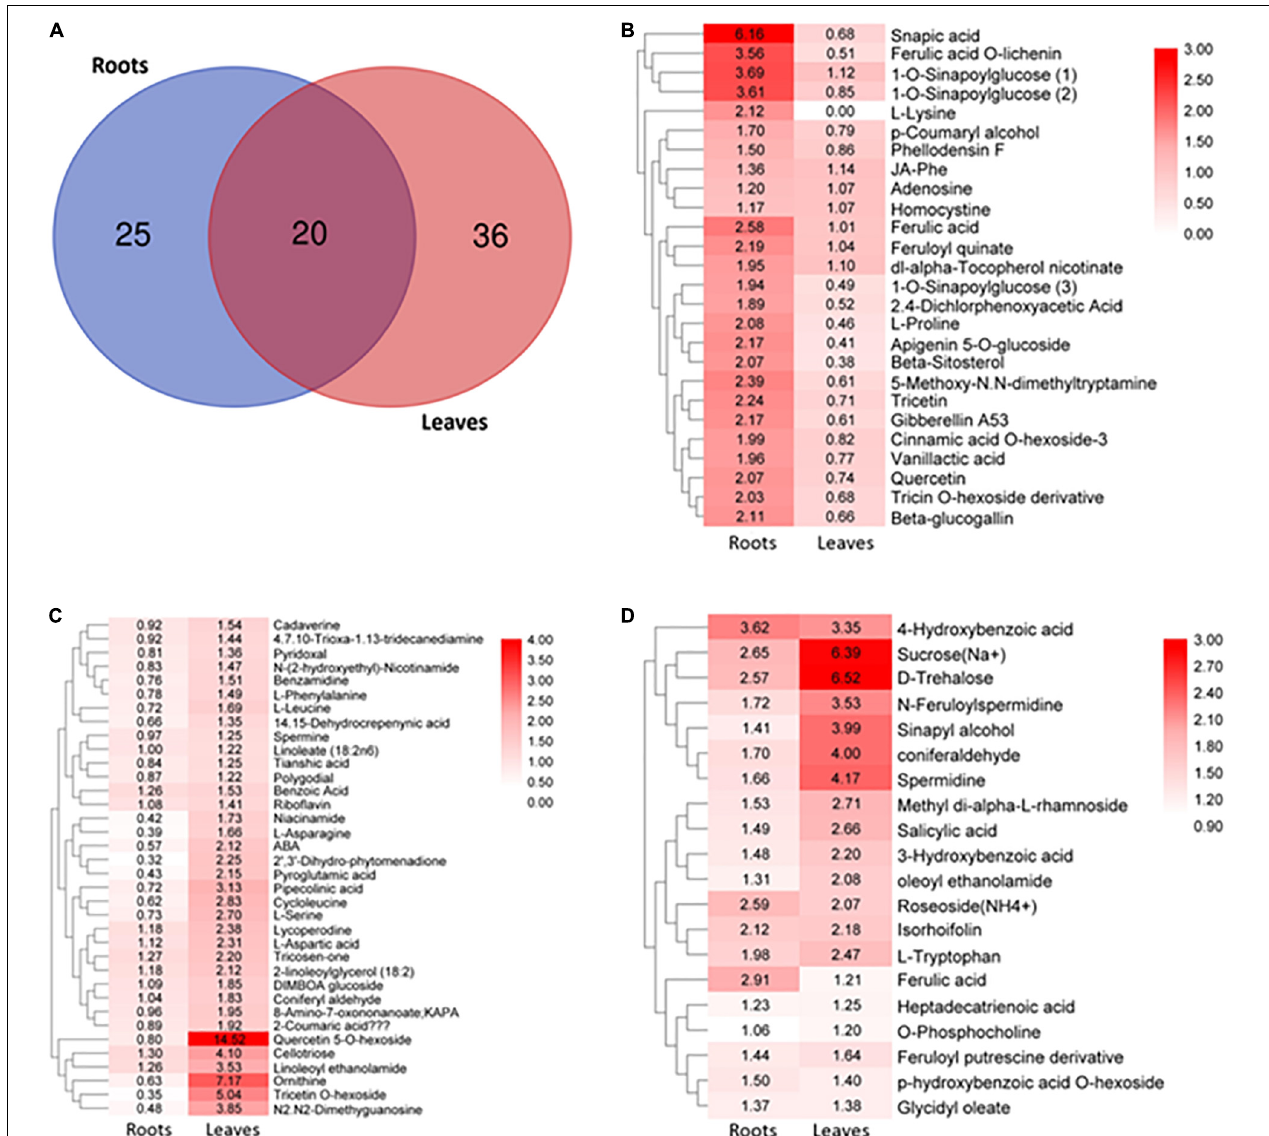
FIGURE 8 | Overview of targeted metabolites in S. argel plants based on liquid chromatography-tandem mass spectrometry (LC-MS/MS) analysis. (A) Differentially accumulated metabolites in the stressed roots (T1_C1) and leaves (T2_C2) as compared to the control ones of S. argel plants; for plants grown below 500 mM NaCl salt, compared with control (free salt), (B) metabolites accumulated in the roots significantly while they accumulated insignificantly in the leaves, (C) metabolites accumulated significantly in the leaves while they accumulated insignificantly in the roots and (D) metabolites accumulated significantly both in the roots and leaves. The number in box plots reflects fold change and the bar on the right reflects log2 fold-change value of the accumulated metabolites. Replications ( n =